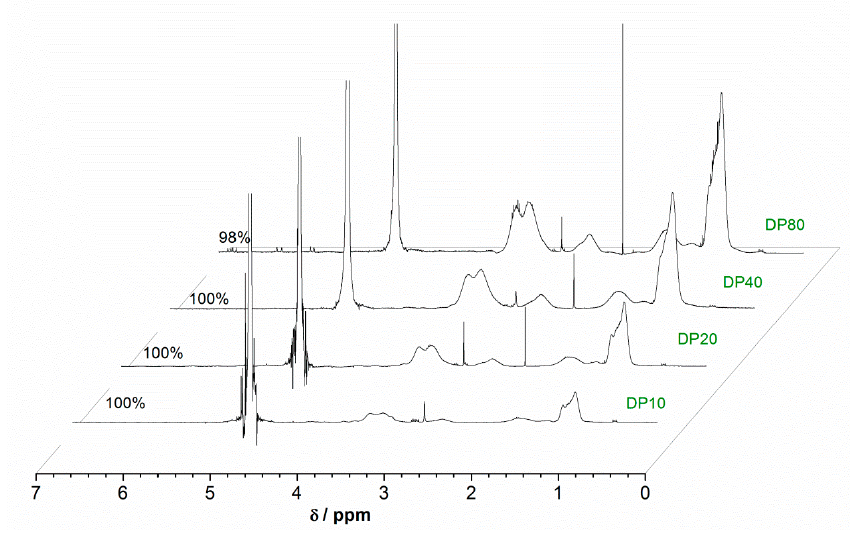
Figure 4. 1 H NMR spectra for Cu(0)-mediated polymerization of PDEA (DP = 10, 20, 40, and 80) in D 2 O.